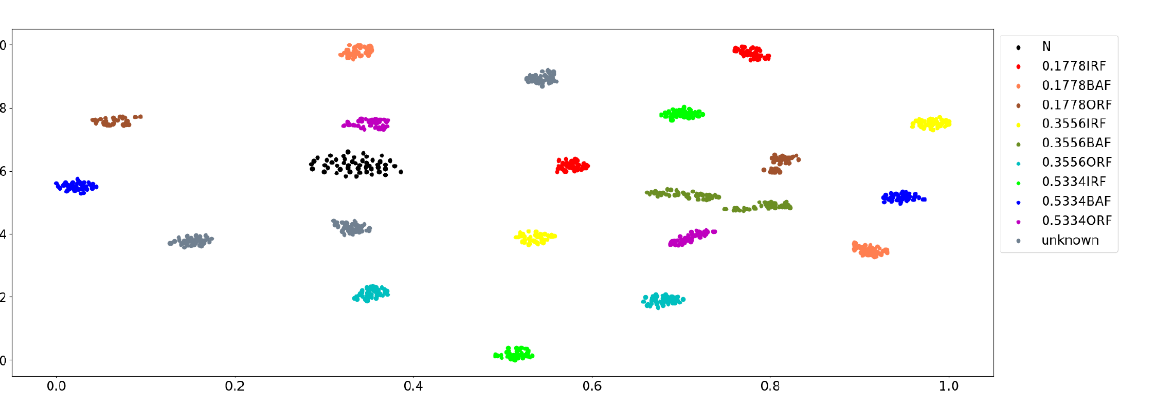
Figure 15. Two-dimensional visualization of the new test set.